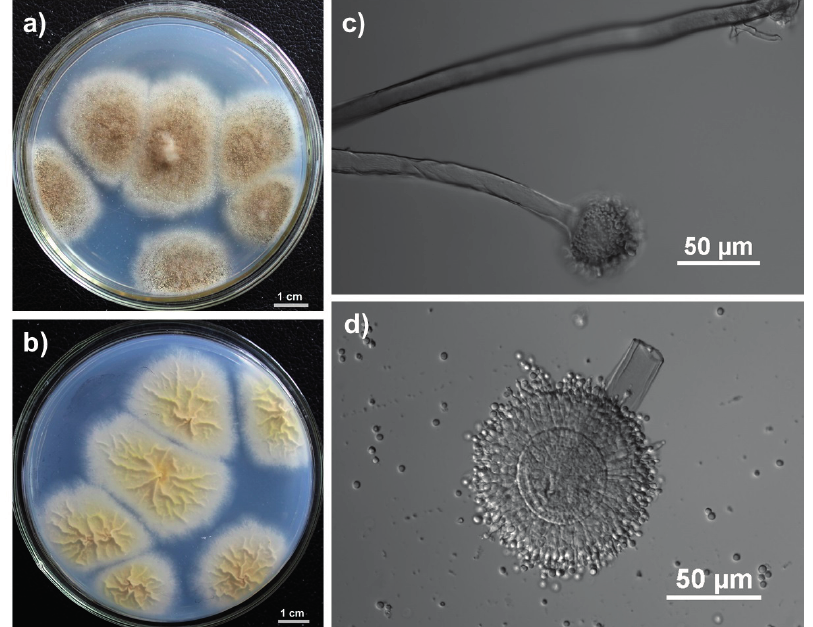
Figure 1. Morphological characteristics of isolate FJBJ11. ( a ) Colonies growing in Czapek’s agar for 7 days; ( b ) The yellowish colonies observed from the reverse side of the Czapek’s agar; ( c ) Sporophore and spherical sporangium; ( d ) Conidia and sporangium with bilayer structure.